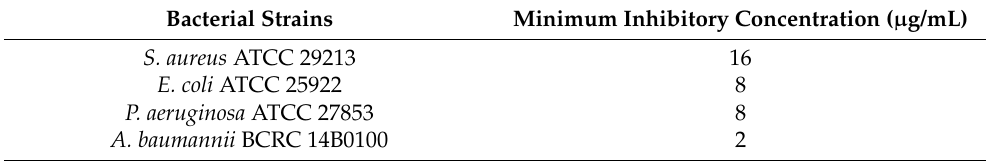
Table 3. MIC values of recombinant CecropinA-AGP-WR6 against Gram-positive and Gram- negative bacteria. Bacterial